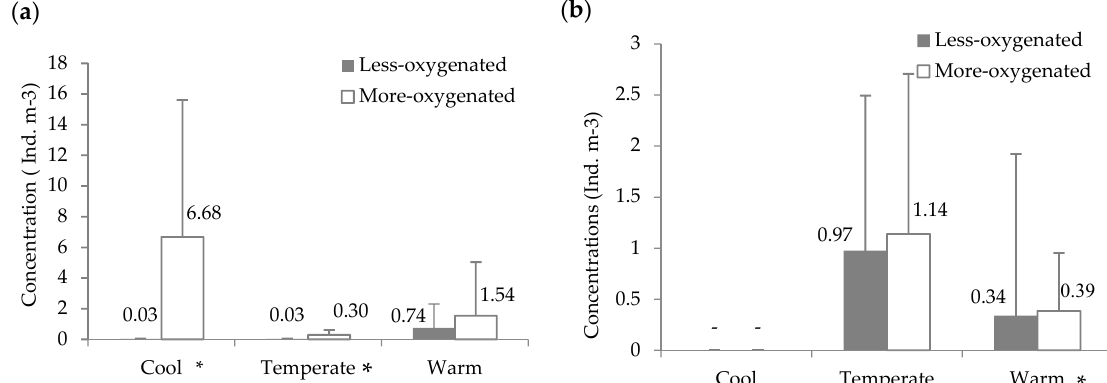
Figure 10. Comparison of ( a ) larval and ( b ) juvenile bay anchovy ( Anchoa mitchilli ) concentrations between More-oxygenated (open bar) and Less-oxygenated (closed bar) subgroups within temperature groups (Cool, Temp, Warm). Numbers indicate average concentrations, error bars indicate standard deviations, and * indicates significant difference in a Kruskal-Wallis test at α = 0.05. The concentrations of larval A. mitchilli were also lower in LO subgroups in each